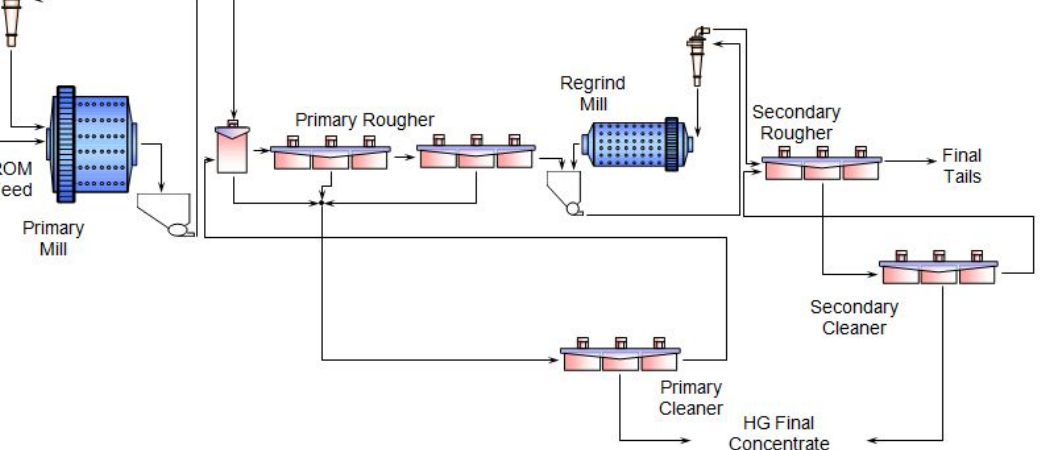
Figure 1. Typical concentration plant for the processing of PGMs, adapted from Engelbrecht